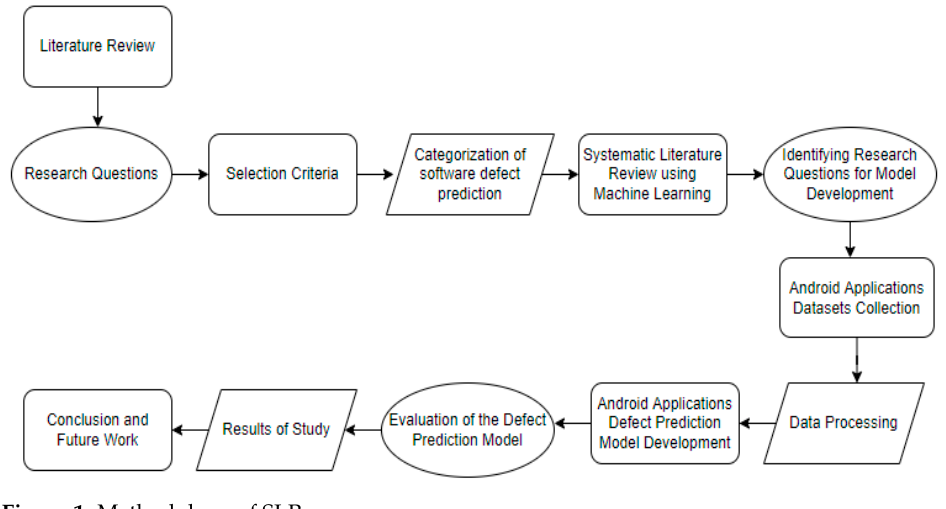
Figure 1. Methodology of